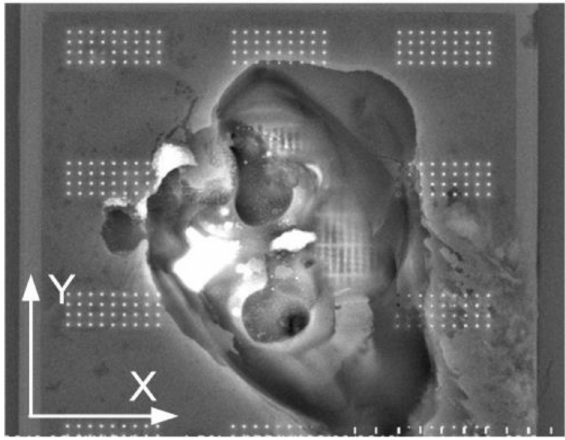
Figure 5. Burn-out damage observed with SEM of a failed 3D NAND Flash test chip